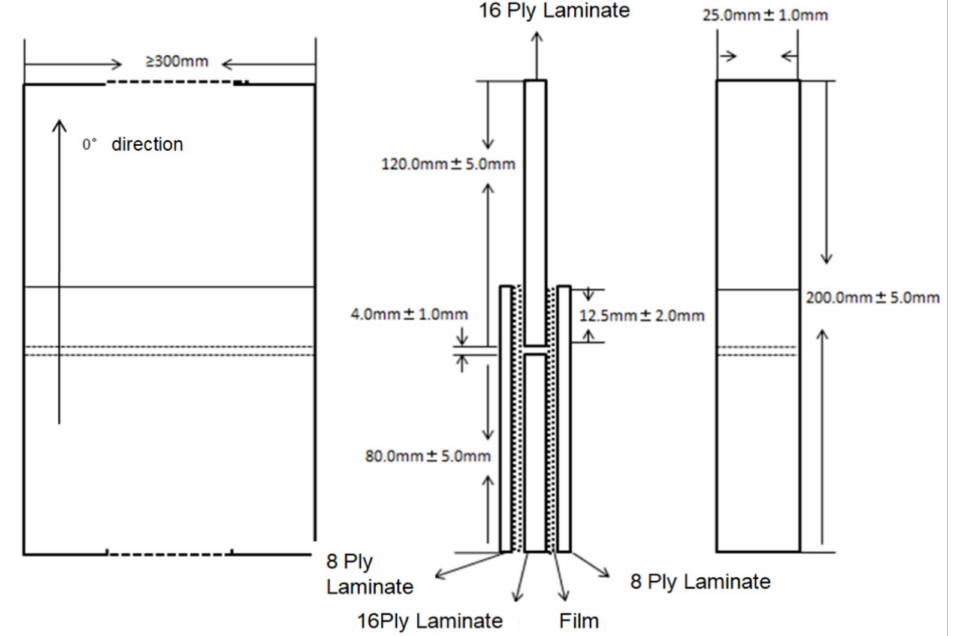
Figure 1. Schematic of a composite sample for double-lap shear